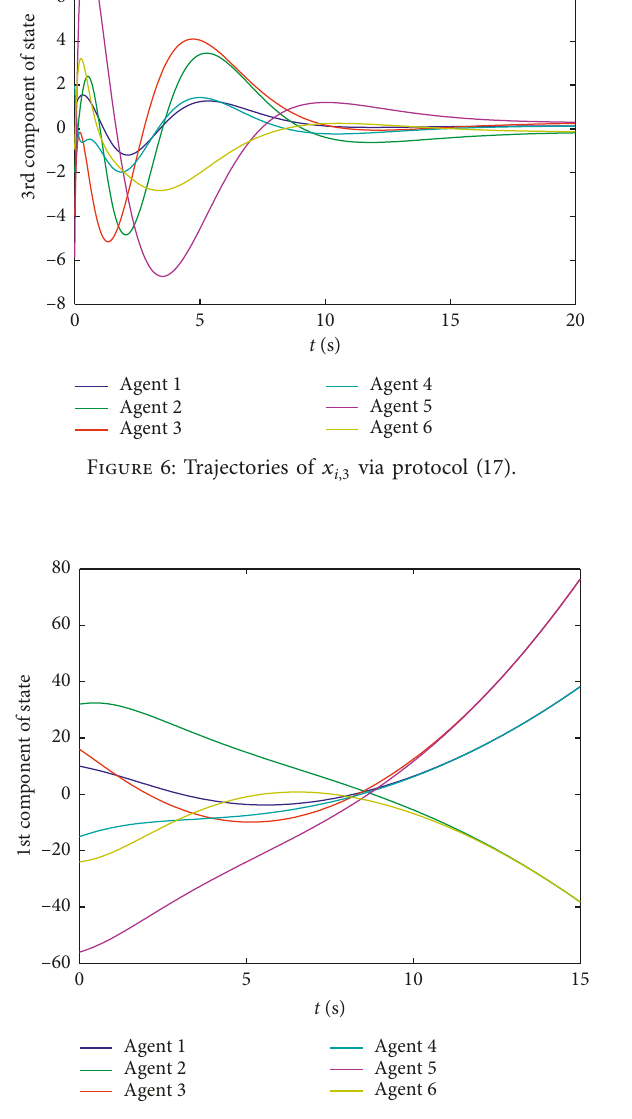
i, 3 via protocol